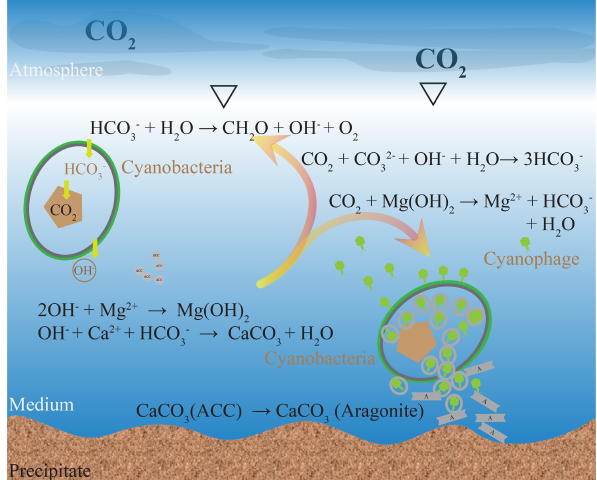
Figure 7. Formation model of the carbonate mineral induced by vi- ral lysis of the cyanobacteria. Although the chemical environment may be favorable for mineral precipitation during photosynthesis, it is unable to facilitate mineralization to the extent that stable CaCO 3 precipitates are formed. During the viral lysis of cyanobacteria, there is a small percentage of uninfected cells that require bicar- bonate; therefore, Mg ( OH ) 2 dissolved to neutralize the dissolution of CO 2 . Thus, the viral lysis of cyanobacteria construct a calcifica- tion environment where carbonate is the dominant inorganic carbon species. Numerous virus particles available in lysate may coprecip- itate with the calcium